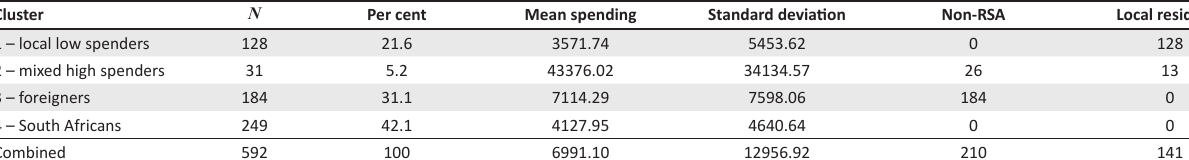
TABLE 1: Results of the cluster